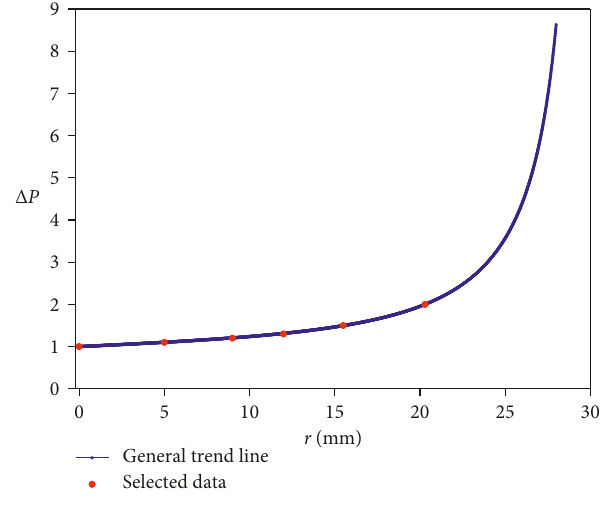
Figure 3: Relationship between